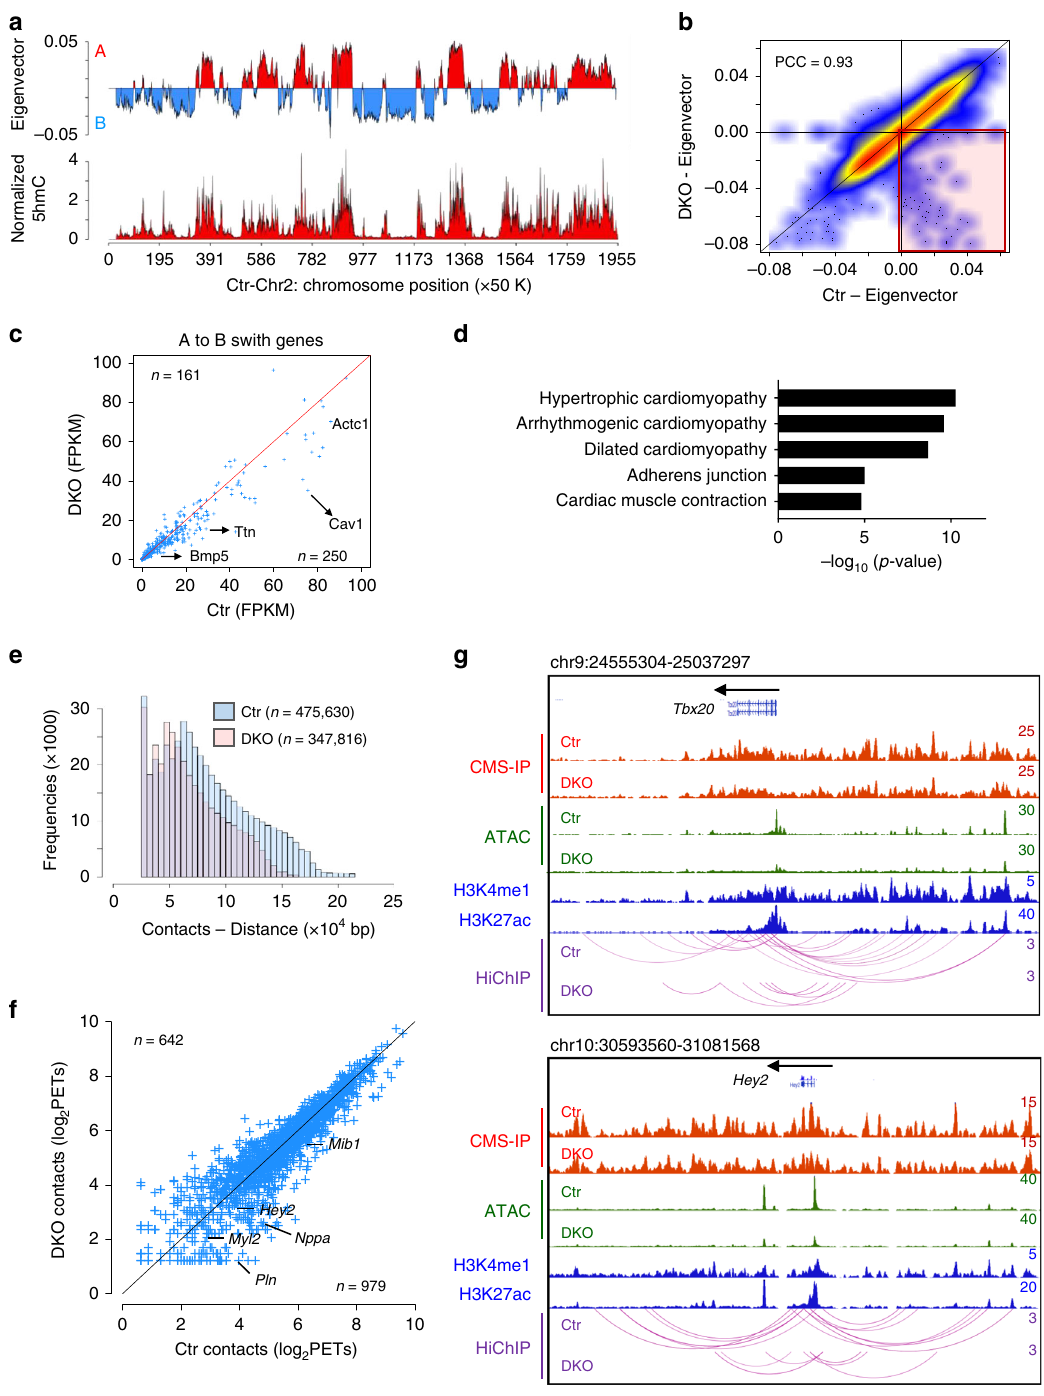
Fig. 7 Tet-mediated DNA hydroxymethylation is associated with chromatin higher-order structures. a Representative histograms of compartment A and B distribution (top) calculated by Eigenvector using HiChIP and CMS-IP-seq (for 5hmC) data over chromosome 2 in E12.5 control embryonic heart tissues. b Scatterplot showing the distribution of Eigenvector calculated in control and Tet2/3-DKO embryonic heart tissues at E12.5. Pearson correlation coef fi cient was calculated. c Expression levels of genes that underwent A-to-B compartment switch in control and Tet2/3-DKO embryonic heart tissues (E12.5). d Representative GSEA analysis of genes located in genomic regions that showed A-to-B compartment switch in Tet2/3-DKO embryonic heart tissues (E12.5). e Histograms of PETs (distance and numbers) from HiChIP data obtained from control and Tet2/3-DKO heart tissues collected at E12.5. f Scatterplot showing the normalized numbers of PETs that overlapped with DEGs (regions ranging from TSS to TTS) in control and Tet2/3-DKO heart tissues collected at E12.5. g WashU Epigenome browser views of 5hmC, ATAC-seq, PETs (HiChIP), H3K4me1 (ENCODE) and H3K27ac (ENCODE) at the Tbx20 and Hey2 loci in control and Tet2/3-DKO heart tissues collected at E12.5